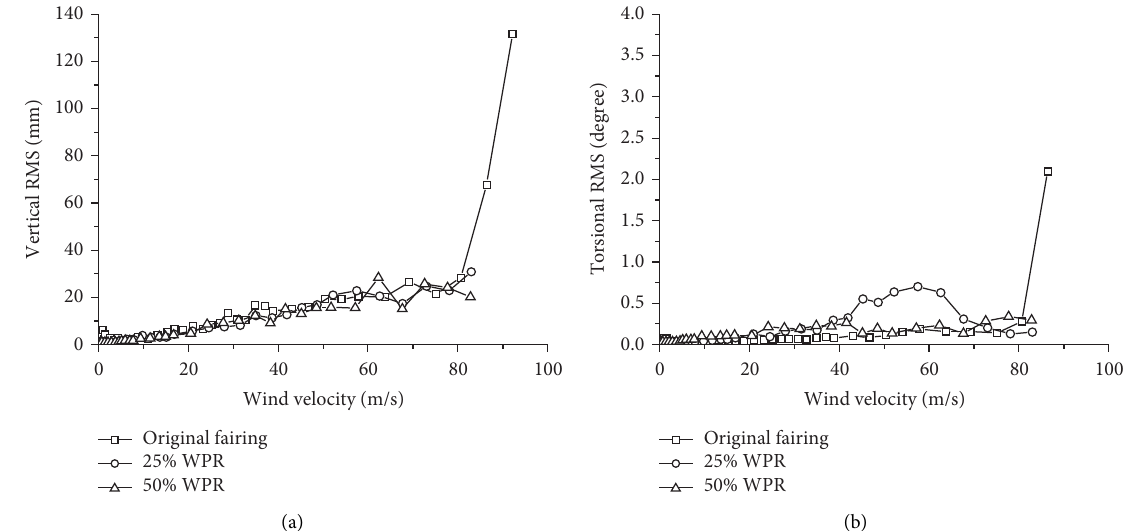
Figure 17: RMS versus wind velocity in turbulent flow (attack angle 0 ° ): (a) vertical RMS; (b) torsional RMS.